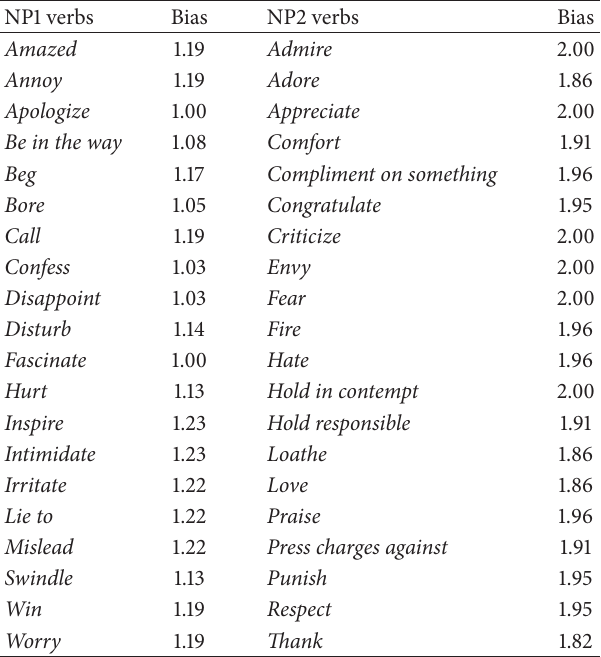
Table 4: System composition comparison of GCAS, GCAS-L, and CL-CIS.